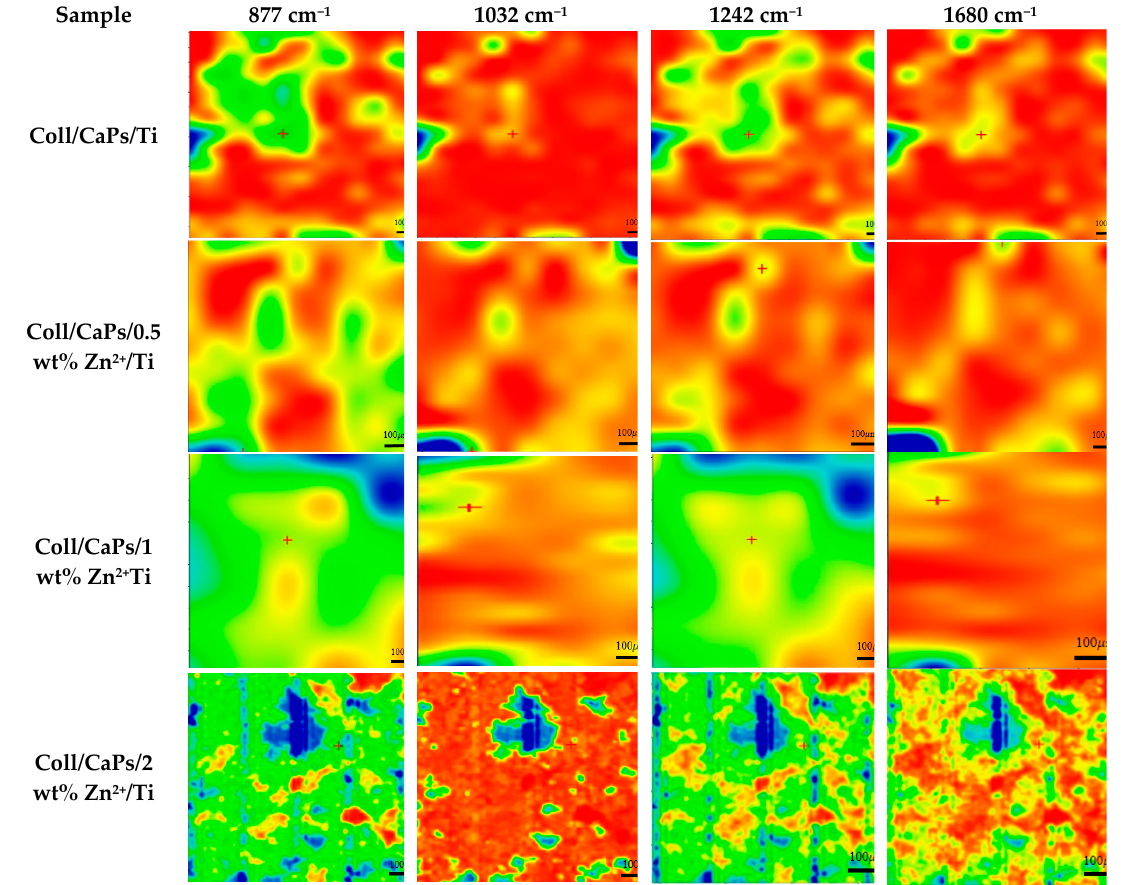
Figure 3. IR mapping of Coll/Zn(II)-CPs thin films deposited on Ti substrate by spin coating.